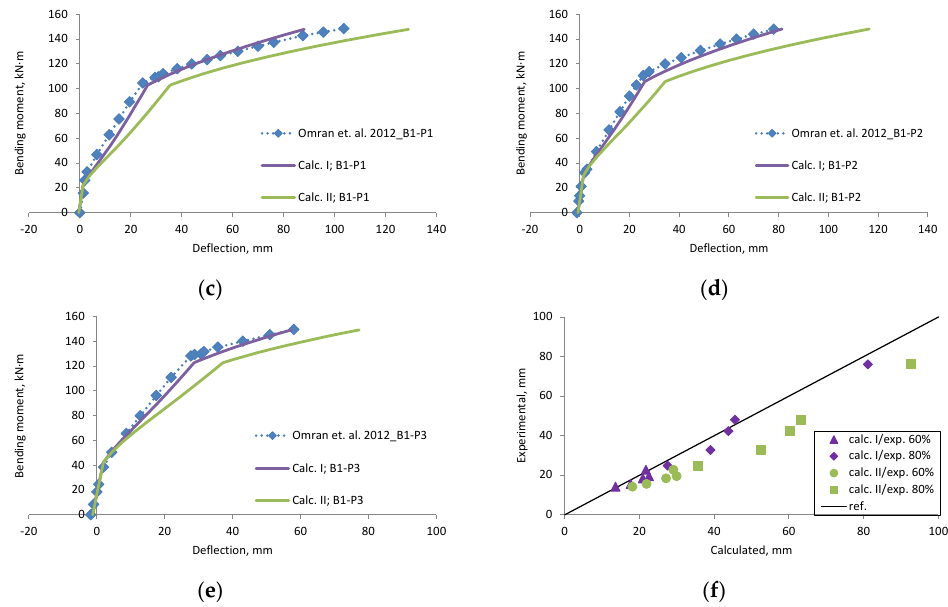
Figure A15. Omran et al., 2012 [38] research beams deflection compared with calculated, ( a ) beam B0; ( b ) beam B1-NP; ( c ) beam B1-P1; ( d ) beam B1-P2; ( e ) beam B1-P3; ( f ) scatter of the results at 60% and 80% of the ultimate load. Materials 2019 , 12 , x FOR PEER REVIEW